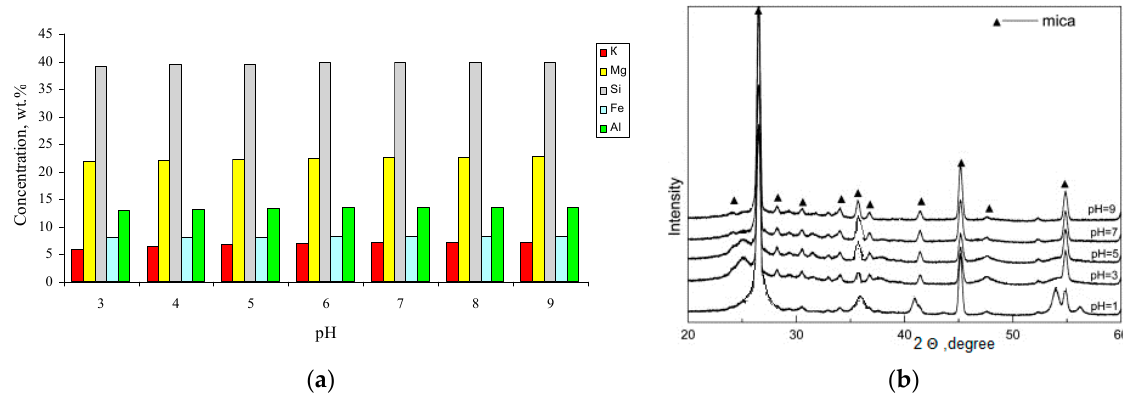
Figure 6. Concentration of main component of phlogopite with different initial pH values ( a ); X-ray diffraction patterns of mica with various pH values of 1, 3, 5, 7, and 9, respectively ( b ).